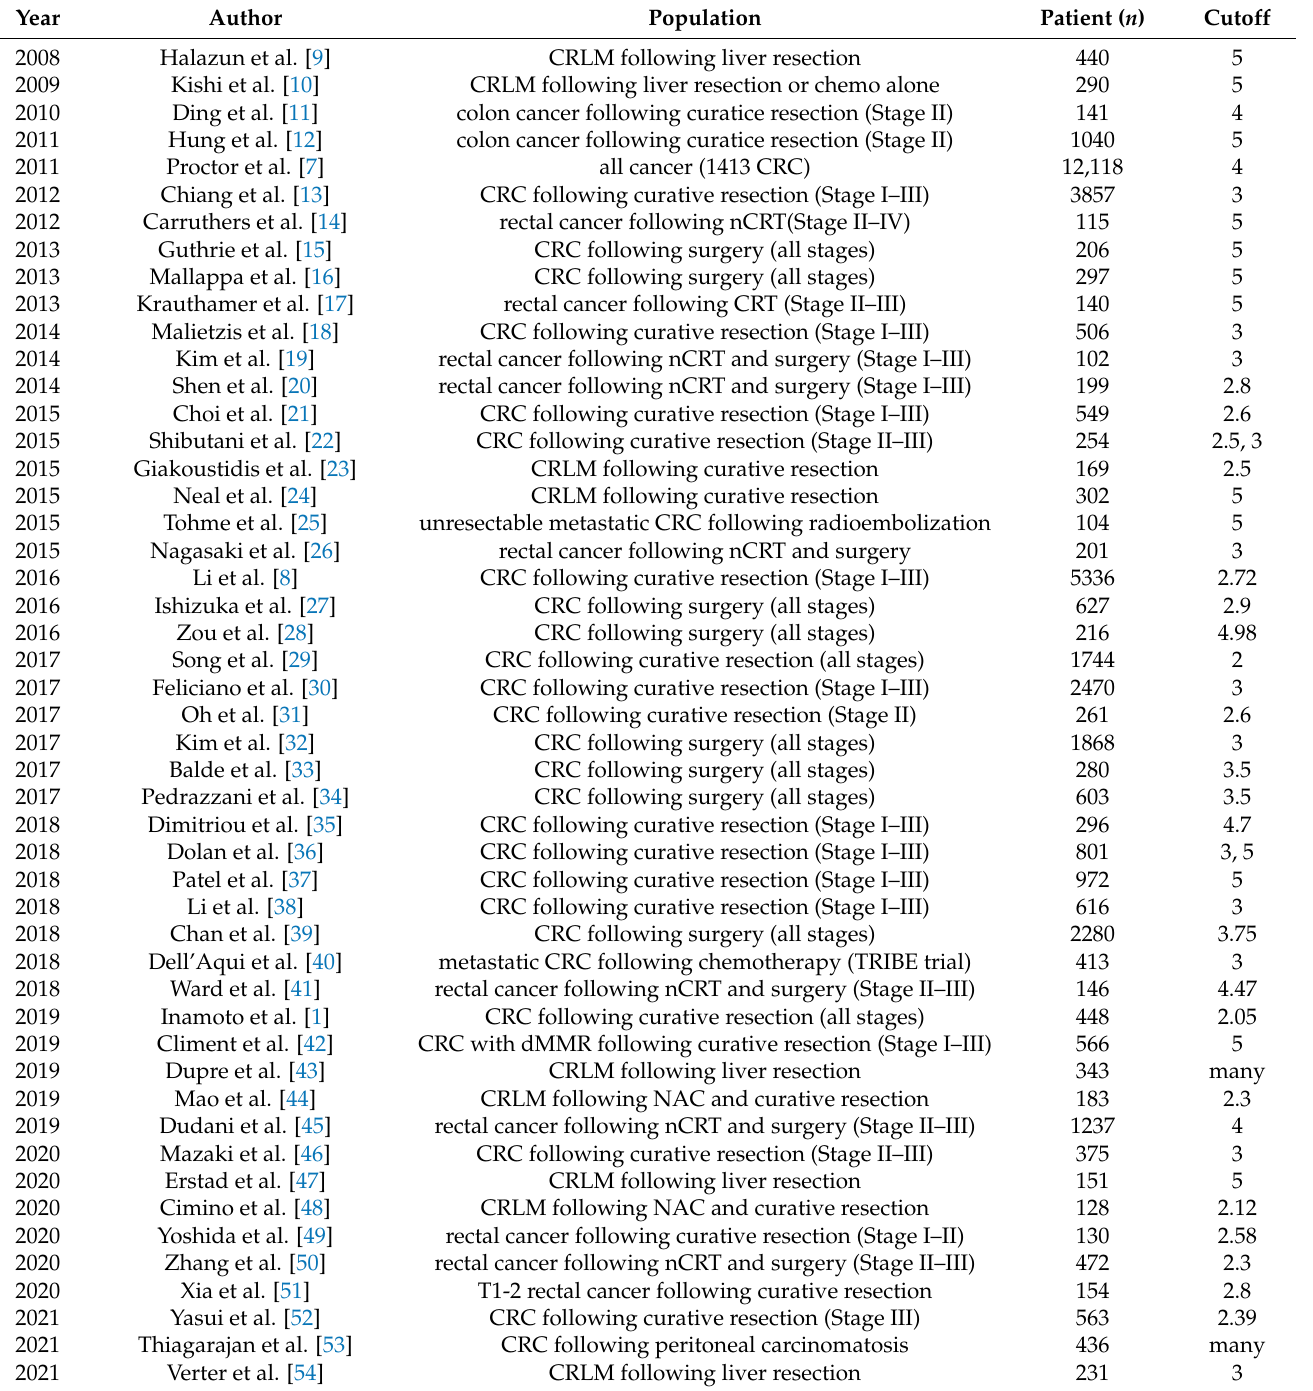
Table 1. Neutrophil–lymphocyte ratio (NLR) in previous reports on colorectal